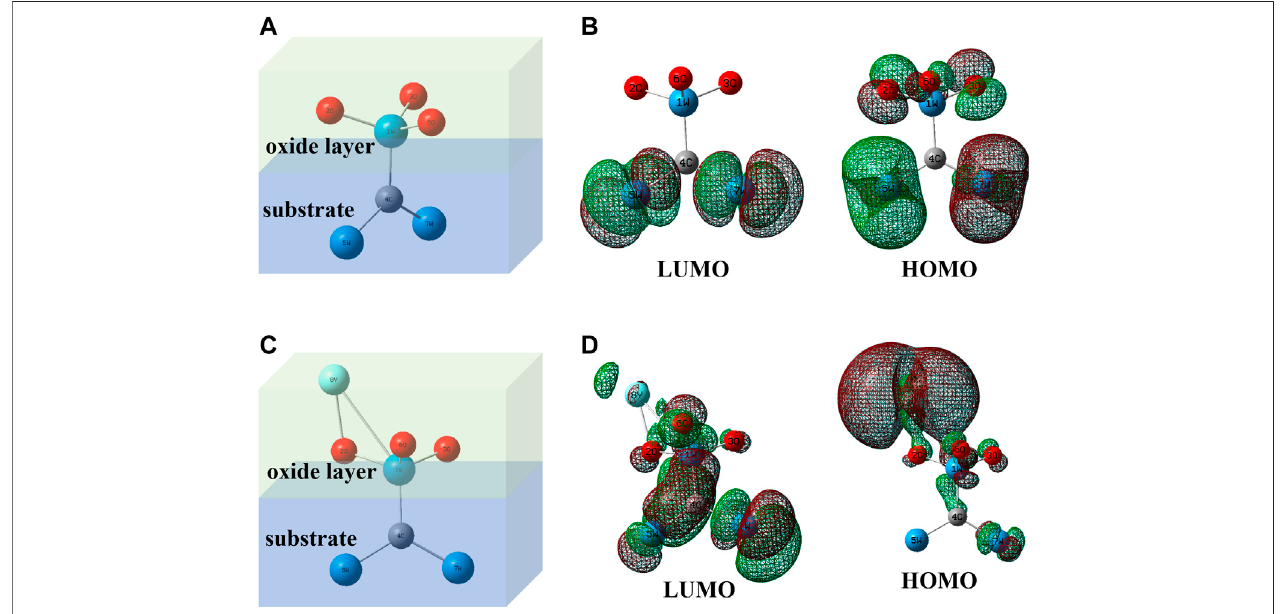
FIGURE 11 | Simpli fi ed oxidation layer/substrate atomic ball-and-stick models of and their electron cloud density simulation diagram. (A) WO 3 /WC; (B) frontier molecular orbits of model (A) ; (C) Y 2 WO 6 /WC; (D) frontier molecular orbits of model (C) .